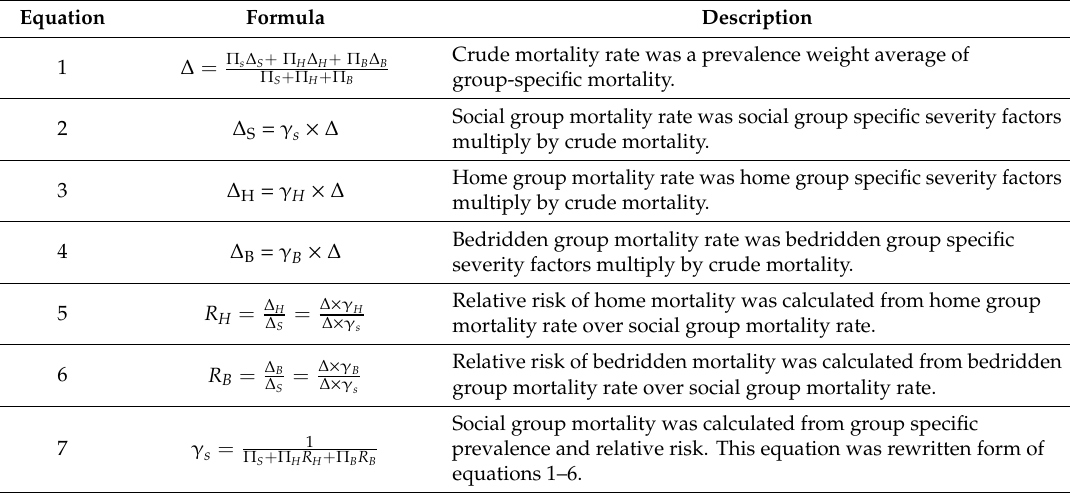
Table 4. Summary of the equations used to estimate group-specific mortality rate.